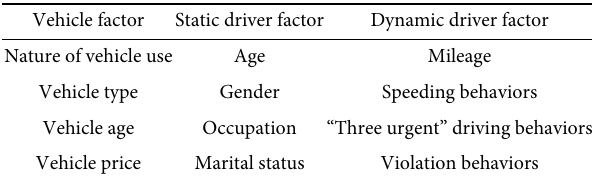
Table 1 Car insurance rate determination factor